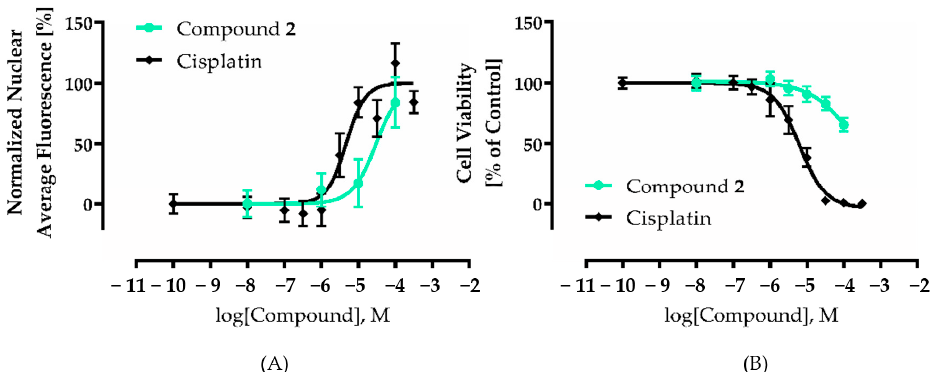
Figure 7. Cytotoxic activity of compound 2 in nuclear shrinkage assay and MTT assay. A2780 cells were incubated with compound 2 and cisplatin in the indicated concentrations for 72 h and effects were investigated with fluorescent based nuclear shrinkage assay ( A ) and MTT assay ( B ). Cell culture medium was added as a control for vehicle treated cells. For normalization of nuclear shrinkage assay effects, the value of the vehicle control was set to 0% and the 24 h 100 µM cisplatin control was set to 100% ( A ). A 24 h ( A ) or 72 h ( B ) treatment with 100 µM cisplatin served as positive control. The bottom value of the concentration effect curve of compound 2 in MTT assay was constrained to the effect of positive control ( B ). Data are the mean ± SD ( A , B ), n ≥ 3. IC 50 , pIC 50 , and SEM derived from four-parameter logistic equation are shown in Table 3. Table 3. IC 50 and pIC 50 for compound 2 and cisplatin in nuclear shrinkage and MTT assay.